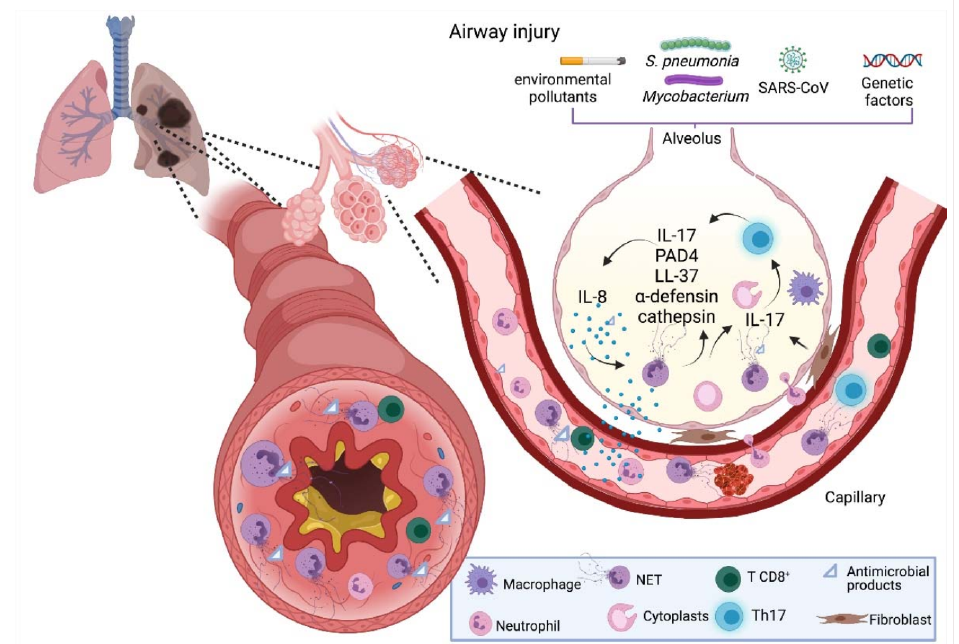
Figure 3. NETs in respiratory diseases. COPD is a multifactor disease caused by physiological and environmental factors (e.g., comorbidities and environmental pollutants) that promote neutrophil recruitment, induce NET formation and contribute to inflammation through LL-37, inducing IL-17 production and hence fibroblast-mediated lung fibrosis. Neutrophilic asthma is mediated by Th17 cells, which cause the upregulation of cathepsin and α -defensin, endogenous production of IL-8 in epithelial cells and induce neutrophil-derived cytoplasts that contribute to Th17 cell differentiation in a PAD4-dependent manner. In pneumonia and TB, NETs have a detrimental role, where they are unable to clear the infection and contribute to the inflammatory state of these pathologies. During Sars-CoV-2 infection, neutrophils are recruited due to a chemokine overexpression (CXCL2 and CXCL8), producing neutrophilia and high NET release, which correlates with disease severity and immunothrombosis. COPD, chronic obstructive pulmonary disease; TB, tuberculosis; NET, neutrophil extracellular trap; IL-8, interleukin-8; IL-17, interleukin-17; PAD4, peptidyl arginine deiminase-4; LL-37, cathelicidin. Created with